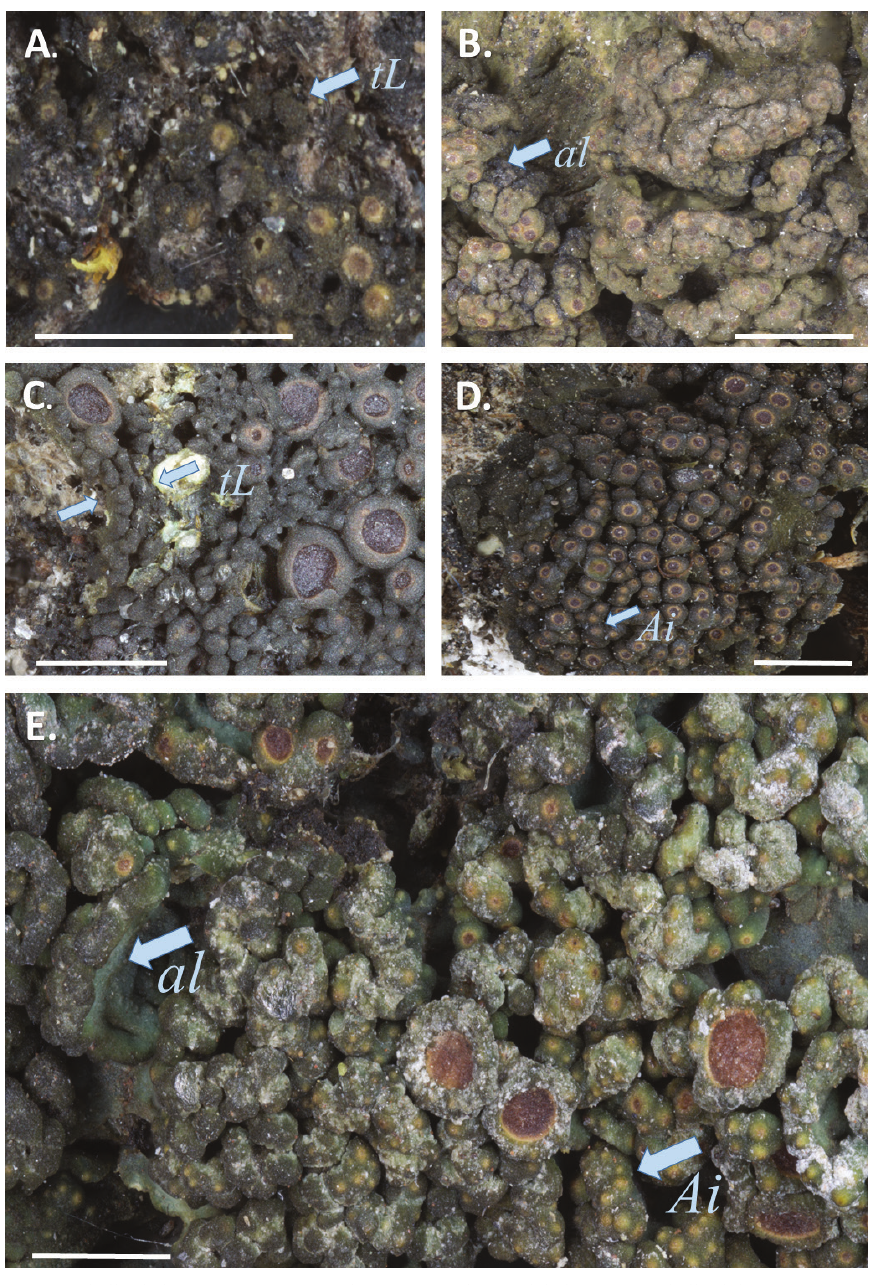
Figure 2. Thallus habitus: A Rostania occultata var. populina (Odelvik 1269, S), thallus lobes (arrow) B Ros- tania multipunctata (Poelt 8852, GZU), accessory lobules (arrow) C Rostania ceranisca (MW_HOCH020, S), accessory finger-like lobules (arrow) D Rostania laevispora (isotype of Collema laevisporum Swinscow & Krog, Tanzania, 1986, Swinscow & Krog T 3/6, O-00298), apothecium in initial stage (arrow) E Rostania callibotrys (Moberg 4431a, UPS), apothecium in initial stage (arrow). tL = thallus lobes, al = accessory lobules, Ai = apothecium in initial stage covering the top of the accessory lobules. Scale bar: 1